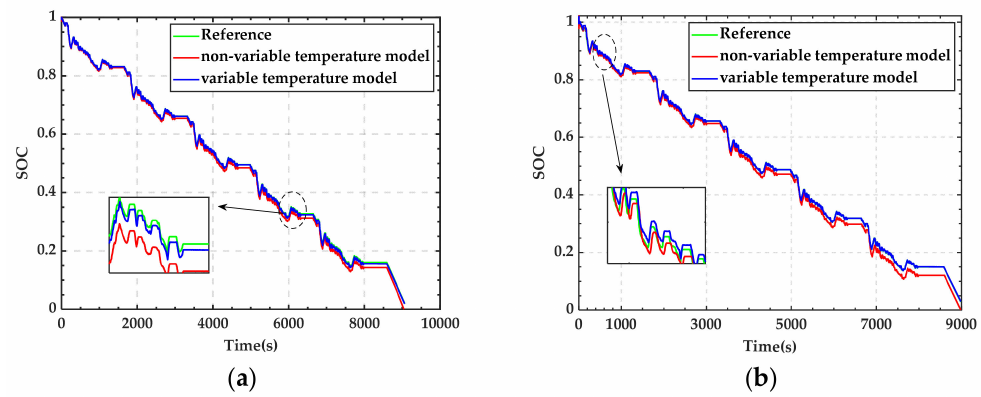
Figure 6. The SOC fusion estimation results with variable and non-variable temperature model at − 10 ◦ C and 40 ◦ C: ( a ) SOC estimation results at − 10 ◦ C; ( b ) SOC estimation results at 40 ◦